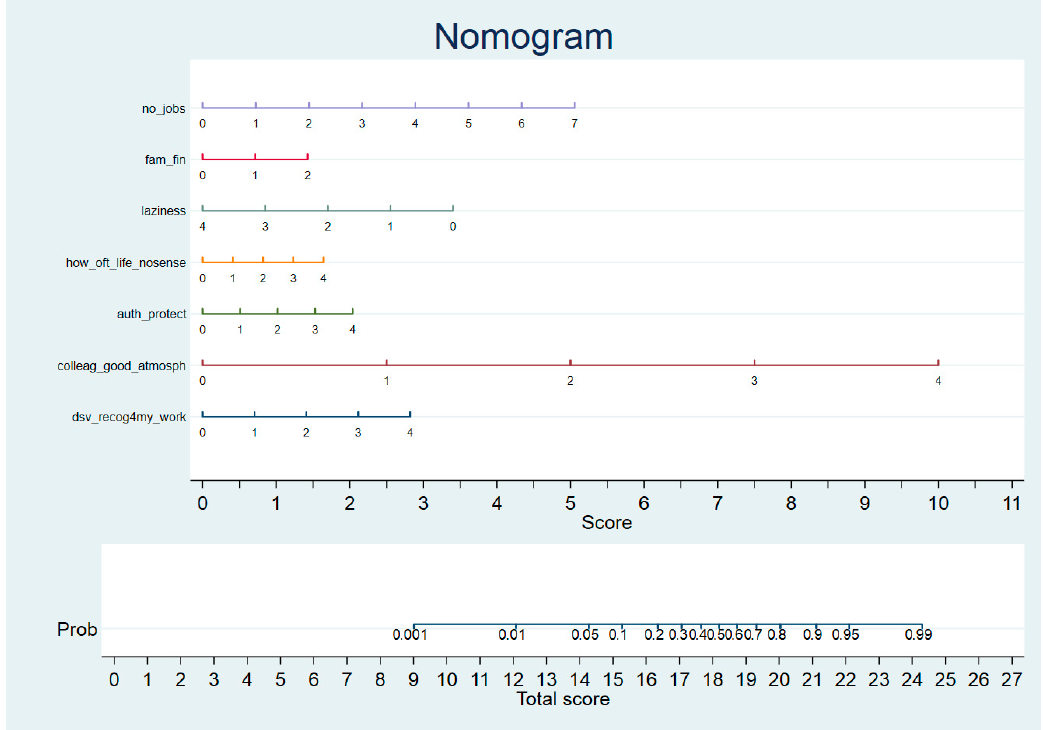
Figure 2. Full job satisfaction prediction nomogram for a regional model (Table 3, scenario a), corresponding to the first Romanian historical region being analyzed (MB).